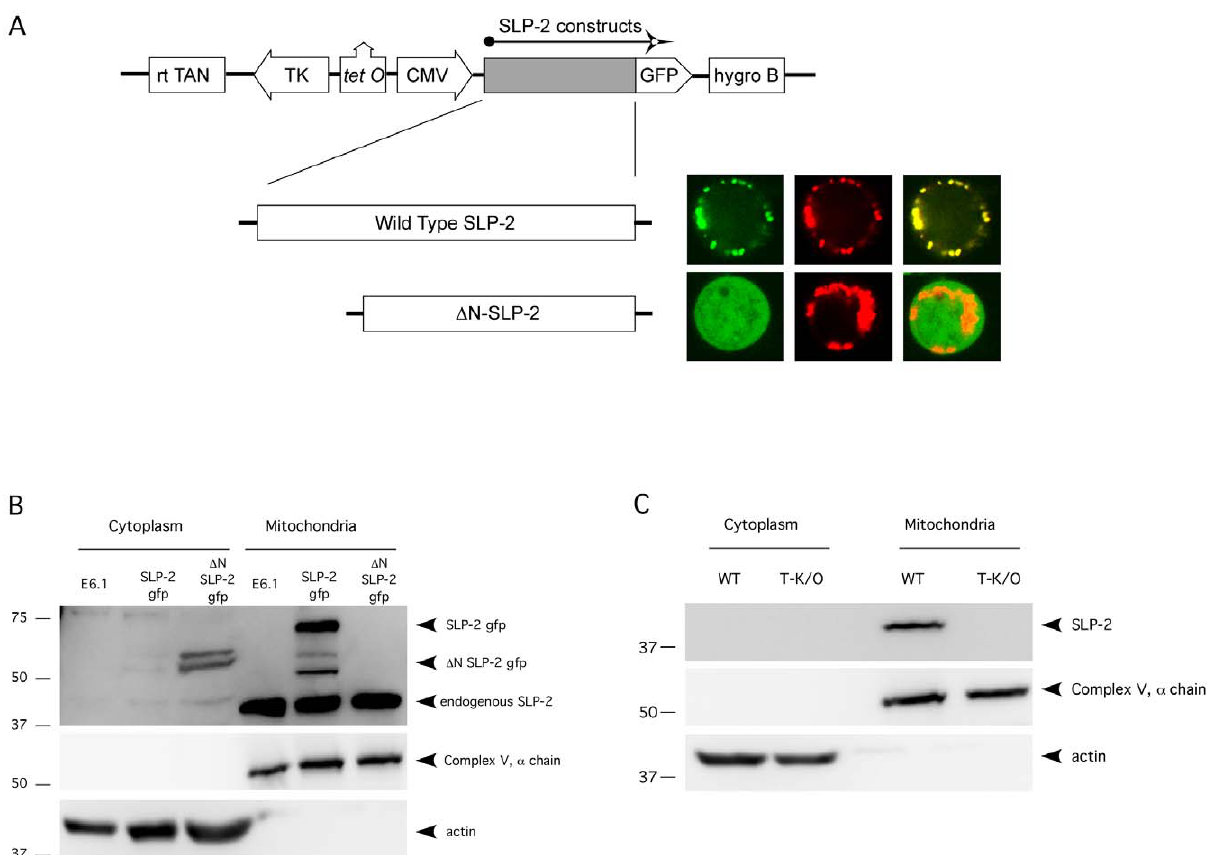
Figure 1. SLP-2 is a mitochondrial protein. A) Full-length SLP-2-gfp and D N-SLP-2-gfp were subcloned into a doxycycline-inducible vector and transfected into Jurkat T cells. These stable transfectants were imaged by confocal microscopy for SLP-2-gfp (first column of micrographs – green), or after staining with MitoTracker Red (second column of micrographs – red). The third colum of photomicrographs show overlapping of red and green signals as yellow signal. B) Mitochondrial and cytosolic fractions of parental, SLP-2-gfp and D N-SLP-2-gfp T cell transfectants were isolated by differential centrifugation and immunoblotted for SLP-2, the a -subunit of ATP synthase and actin. C) Mitochondrial and cytosolic fractions were isolated from T cells of wild type mice and T-cell specific SLP-2 conditional knockout mice and blotted as in B. These results are representative of at least 3 independent experiments, and of more than 100 imaged cells.